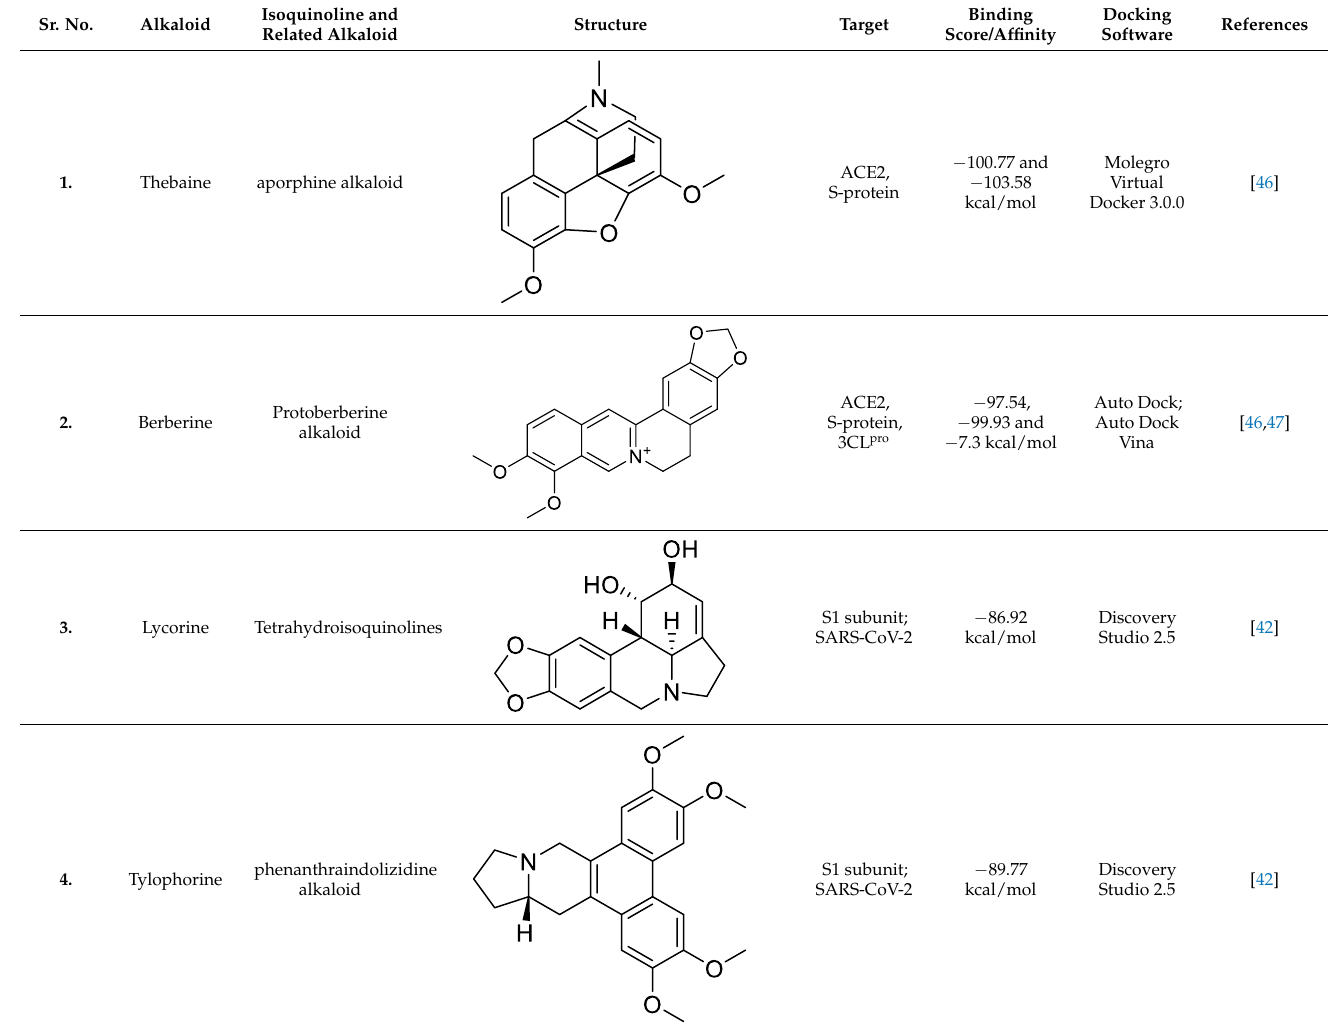
Table 1. In silico binding affinities of isoquinoline and related alkaloids against SARS-CoV-2. Sr. No.